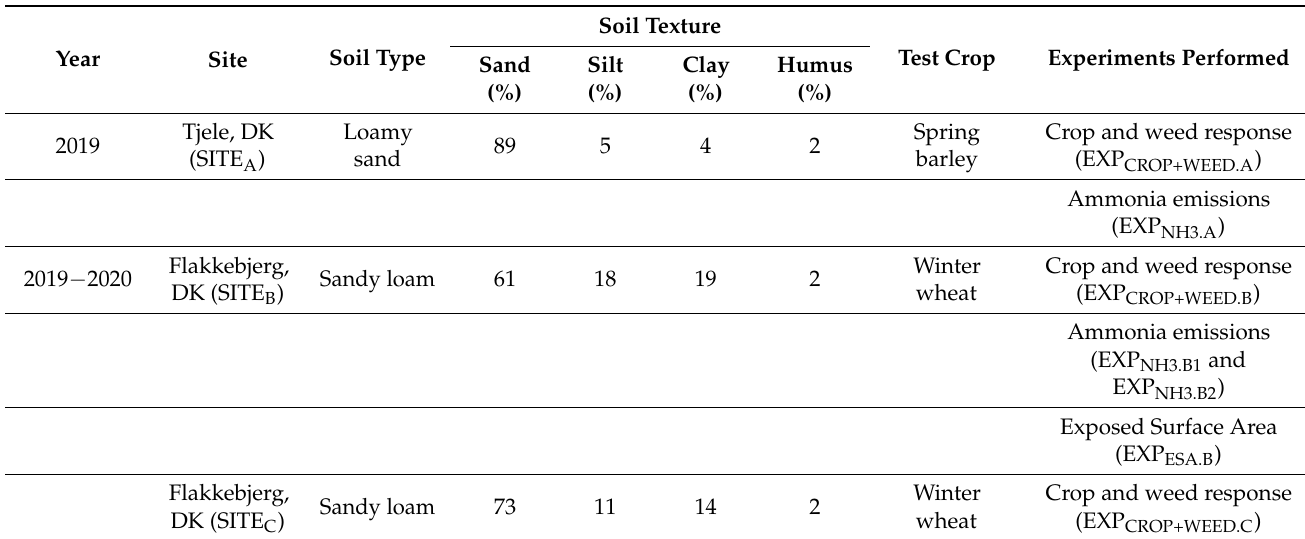
Table 1. Overview of experiments performed in 2019 and 2020 across